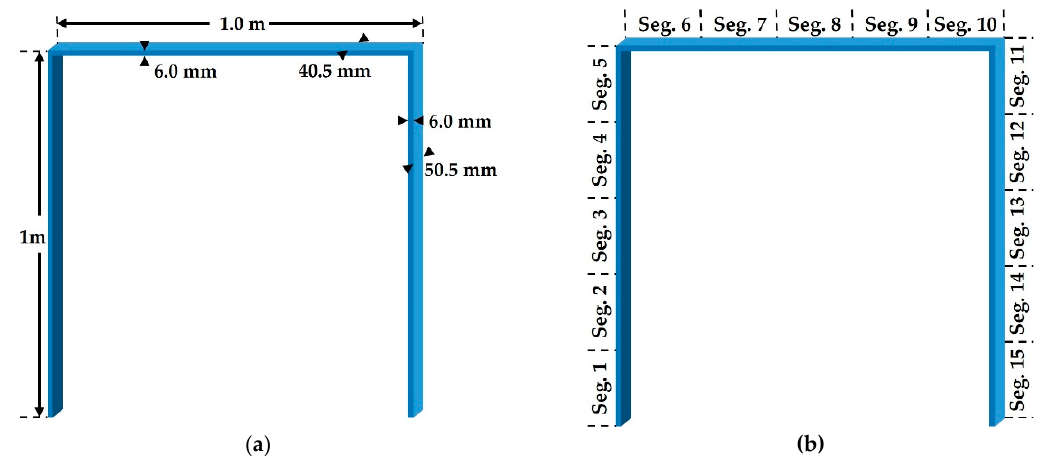
Figure 4. Portal Frame: ( a ) Specification; ( b ) Segments [45].